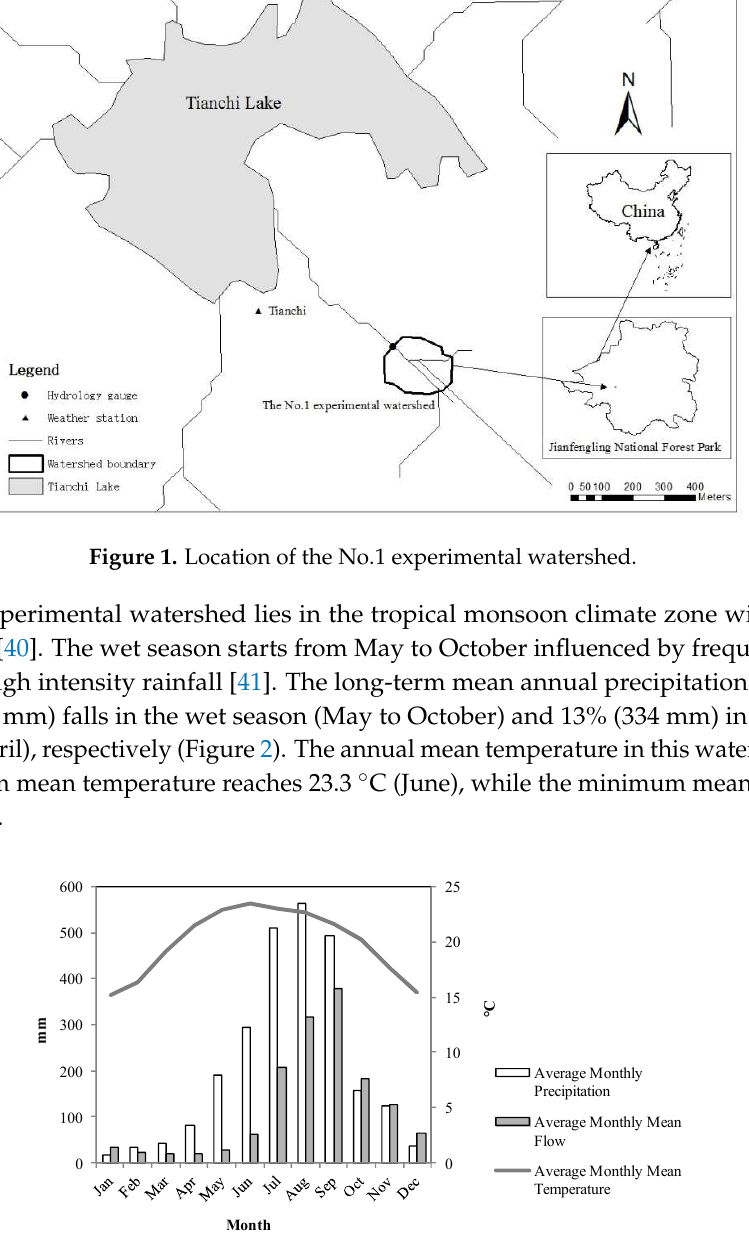
Figure 2. The averages of monthly mean precipitation, flow, and temperature from 1990 to 2005 in the No.1 experimental watershed.